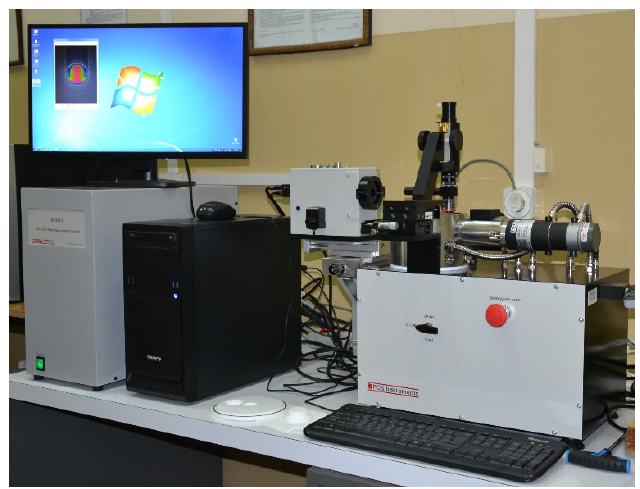
Figure 5. Photo of the EHD2 System for oil film thickness measurement. The stationary ball was pressed against the rotating disc (Figure 6) with the load of 20 N and 30 N. The sliding velocity during the test was in the range of 0.1 to 0.2 m/s. The sliding pair was lubricated with CAS 8042-47-5 mineral oil at the ambient temperature.